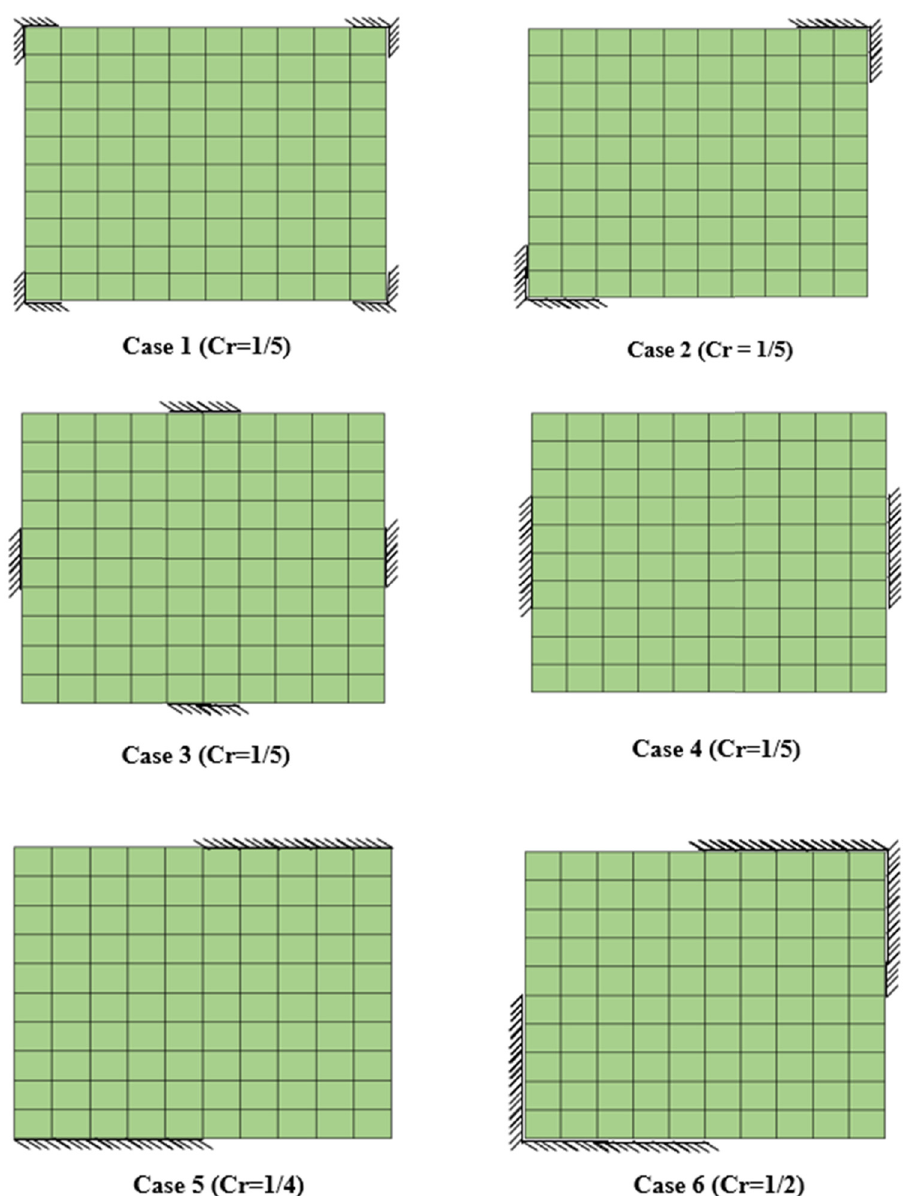
Figure 18: Schematic representation of di ff erent unconventional boundary conditions with various clamping ratio ’ s ( Cr )